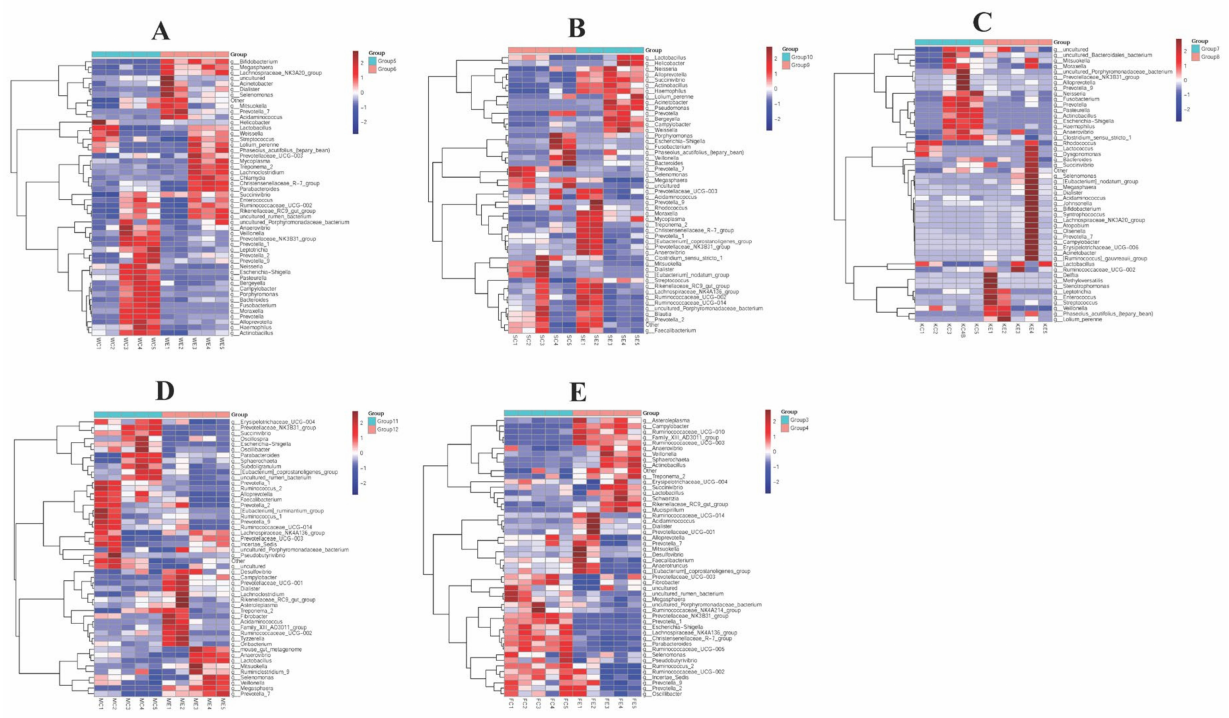
Figure 5. Heatmap showing the efficacy of colistin on piglet microbiome change at genus levels. ( A ) Stomach (Group 6, Group 5); ( B ) duodenum (Group 10, Group 9); ( C ) jejunum (Group 8, Group 7); ( D ) cecum (Group 12, Group 11); ( E ) feces (Group 4, Group 3); colistin treated group: Group 6 (WE1, WE2, WE3, WE4, WE5), group 10 (SE1, SE2, SE3, SE4, SE5), group 8 (KE1, KE2, KE3, KE4, KE5), Group 12 (ME1, ME2, ME3, ME4, ME5), and Group 4 (FE1, FE2, FE3, FE4, FE5); control group: Group 5 (WC1, WC2, WC3, WC4, WC5), Group 9 (SC1, SC2, SC3, SC4, SC5), Group 7 (KC1, KC2, KC3, KC4, KC5), Group 11 (MC1, MC2, MC3, MC4, MC5), and Group 3 (FC1, FC2, FC3, FC4,